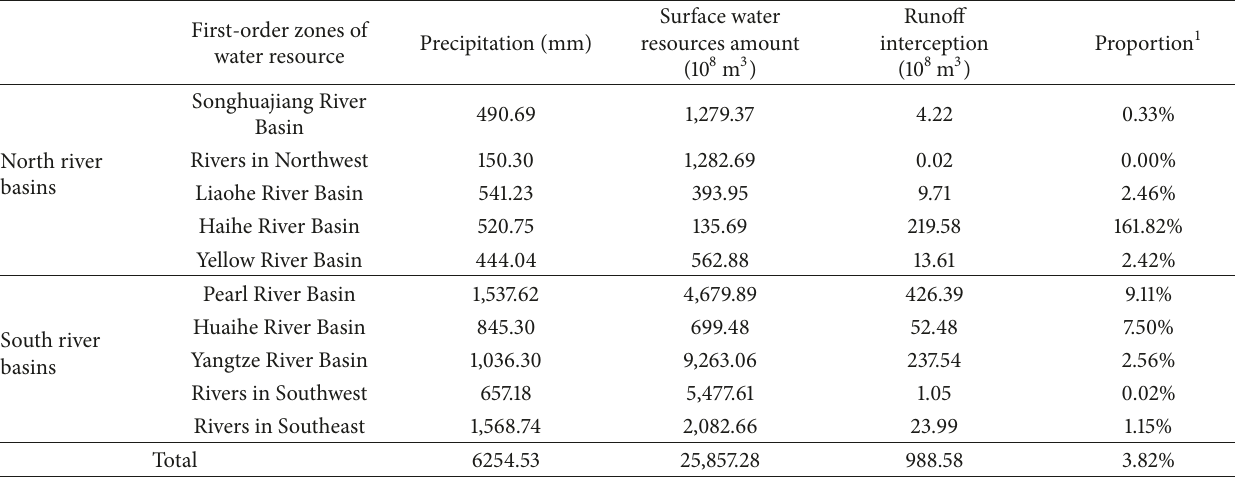
Table 1: Annual average precipitation (1961–2011), runoff interception (1961–2011), and surface water resources amount (2005–2014) of first- order zones of water resource in